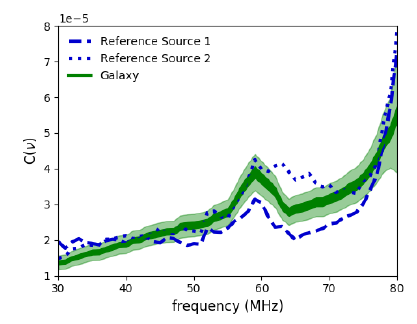
Figure 2. Calibration function for LOFAR data as determined using galactic emission and electronic noise (in green), and compared to the calibration functions derived using a reference source (blue) The di ff erent reference source calibrations come from di ff erent calibrations of the reference source itself. The width of the dark green line represents statistical uncertainties. The frequency dependent systematic uncertainties are indicated by the light green band, and reach a maximum of 14 % below 77 MHz.